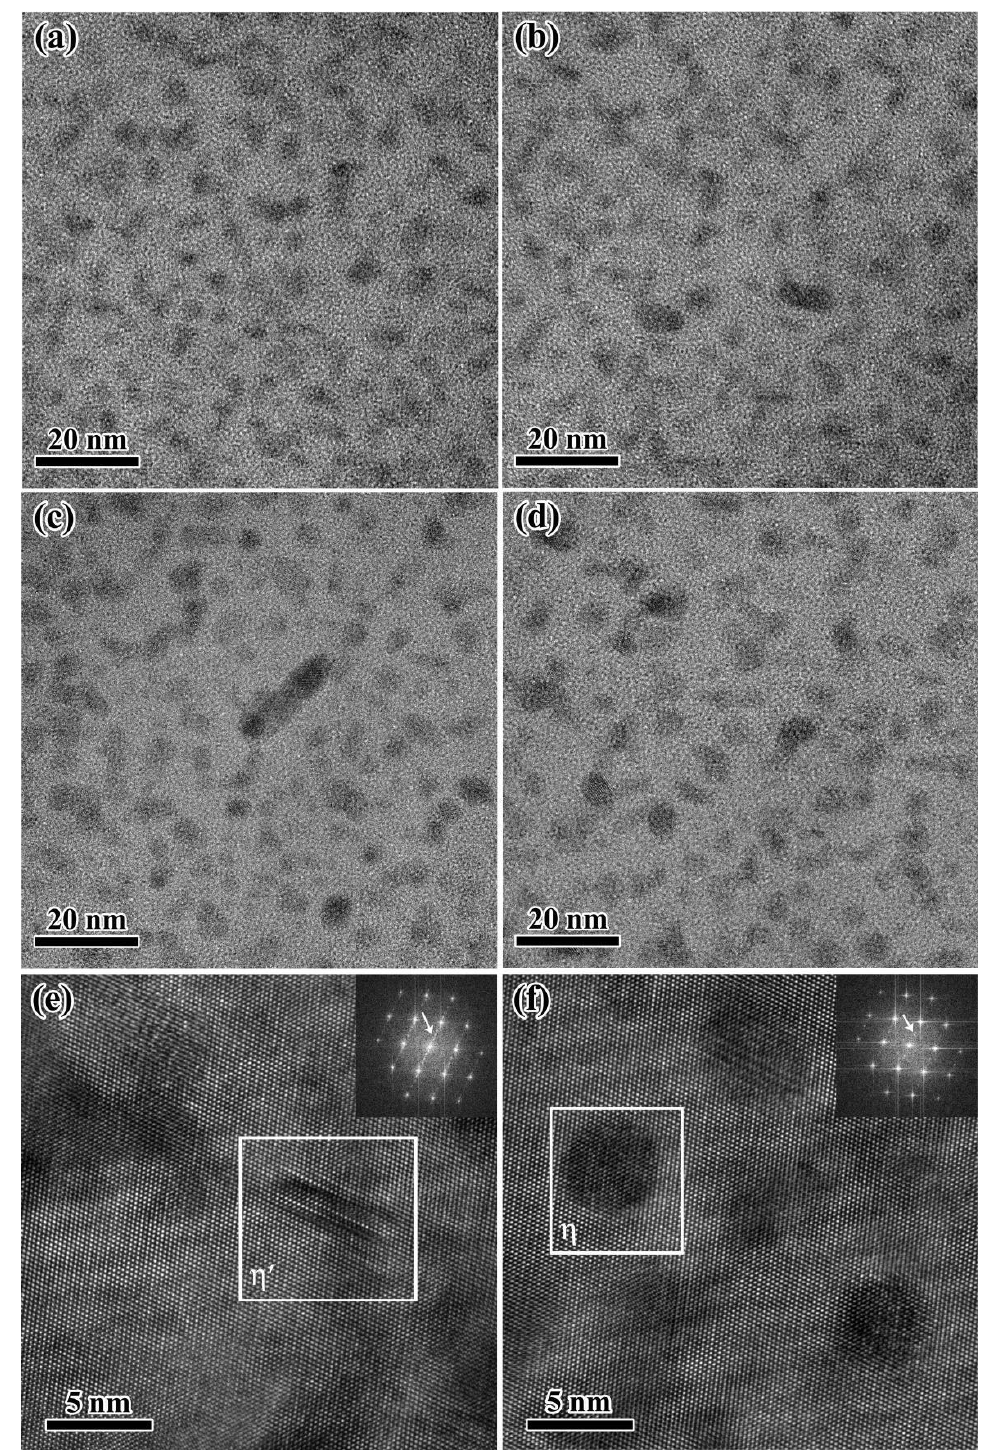
Figure 4. Higher magnification TEM images of precipitates after aging at 120 °C for 28 h with different strains: ( a ) 0; ( b ) 0.10; ( c ) 0.15; ( d ) 0.20; <011> Al FFT of the ( e ) rod-like η′ phase and ( f ) disk η phase.